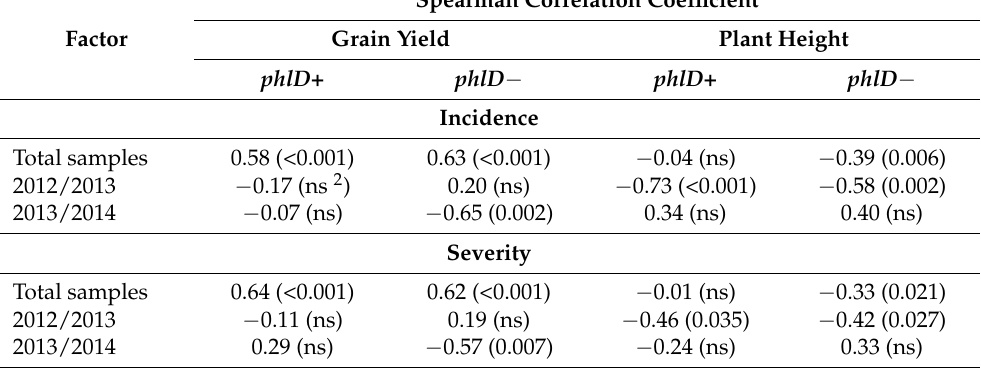
Table 5. Spearman correlation coefficients for the incidence and severity of damage versus yield (ton ha − 1 ) and plant height (cm) observed in four intensively sampled fields from southern Chile, analyzing the total collected samples (n = 96), sampling year (2012/2013; n = 48 and 2013/2014; n = 48), and considering those sampled points 1 that presented positive bacterial populations (only+) and negative (only − ) to the gene phlD . Spearman Correlation Coefficient Factor Grain Yield Plant Height phlD+ phlD − phlD+ phlD − Incidence Total samples 0.58